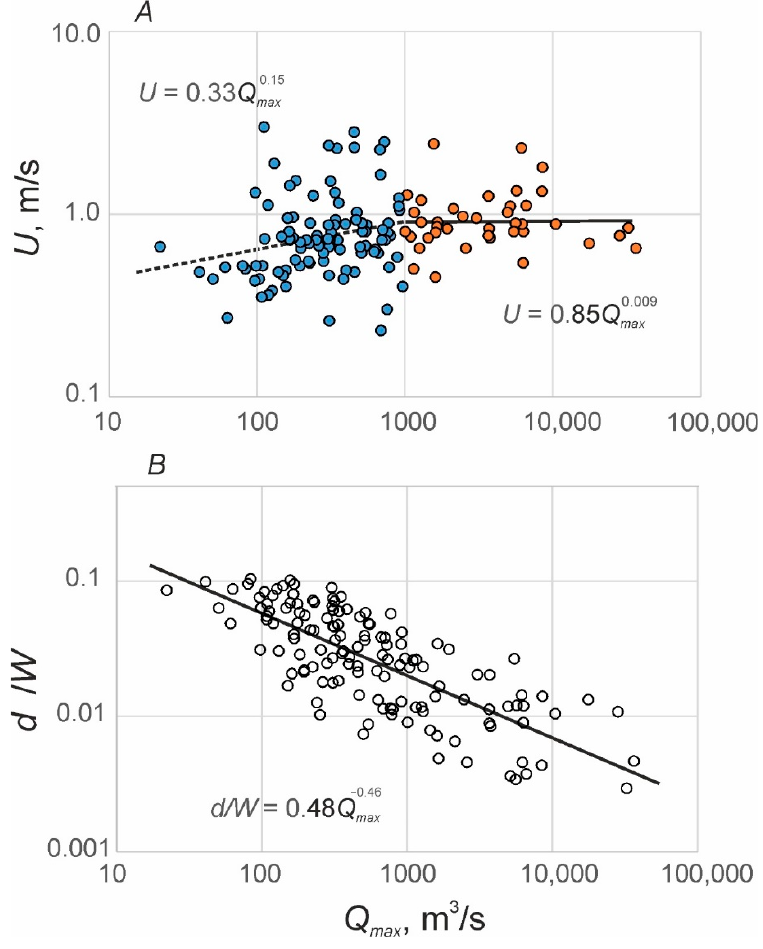
Figure 9. Downstream changes of hydraulic geometry of the rivers of West Siberia with mean maximum discharge Q max : ( A )—of flow velocity U for the rivers with Q max < 1000 m 3 /s (blue circles) and Q max > 1000 m 3 /s (red circles); ( B )—of depth to width ratio d / W